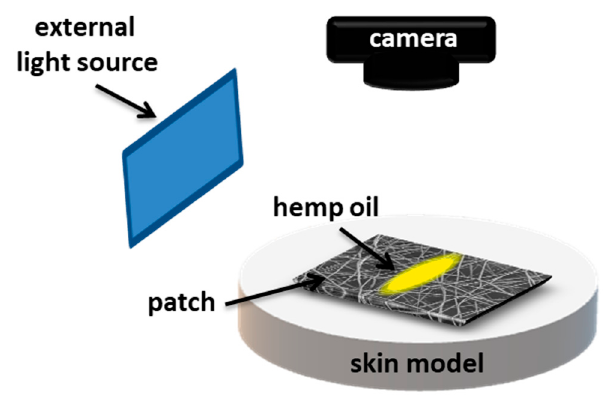
Figure 1. Schematic of the experimental set-up showing oil spreading on electrospun patches placed on gelatin-based skin model.